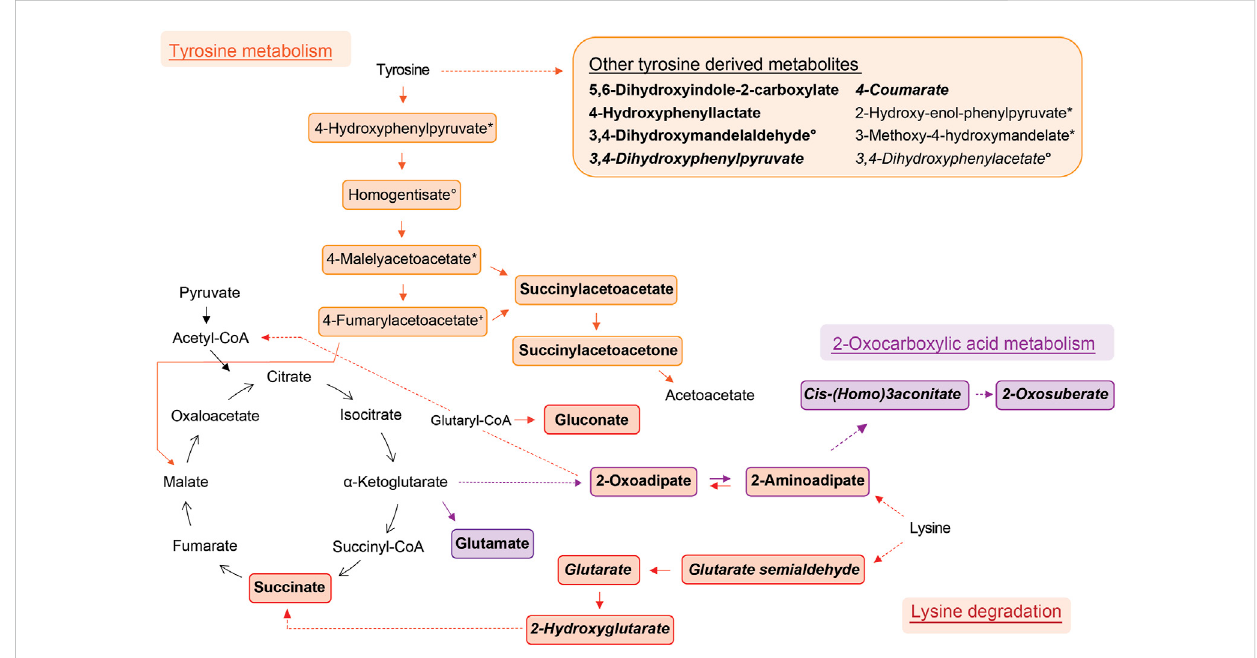
FIGURE 2 Schemesofmetabolic pathwayswell-representedbycompoundsthatwereelevatedintheallergicasthmagroupandputativelyidenti fi ed.Tyrosine derivedmetabolitesbesidesthemaindegradationpathwayinhumansaresummarisedinthebox.Twounrelatedcompoundsofthe2-oxocarboxylicacid metabolism are not shown (see Table 2). Solid lines: direct metabolic relations; dashed lines: indirect metabolic relations (metabolites in between were notidenti fi ed);colored:putativelyidenti fi edcompound;bold:identi fi edbyMS 2 ,regular:identi fi edbasedonexactmassandpathwaymapping,oron literature; italic: metabolites from gut microbiota; *, ° , + , # , ^ , ‘ : several possibilities for 1 m/z feature based on exact mass and pathway